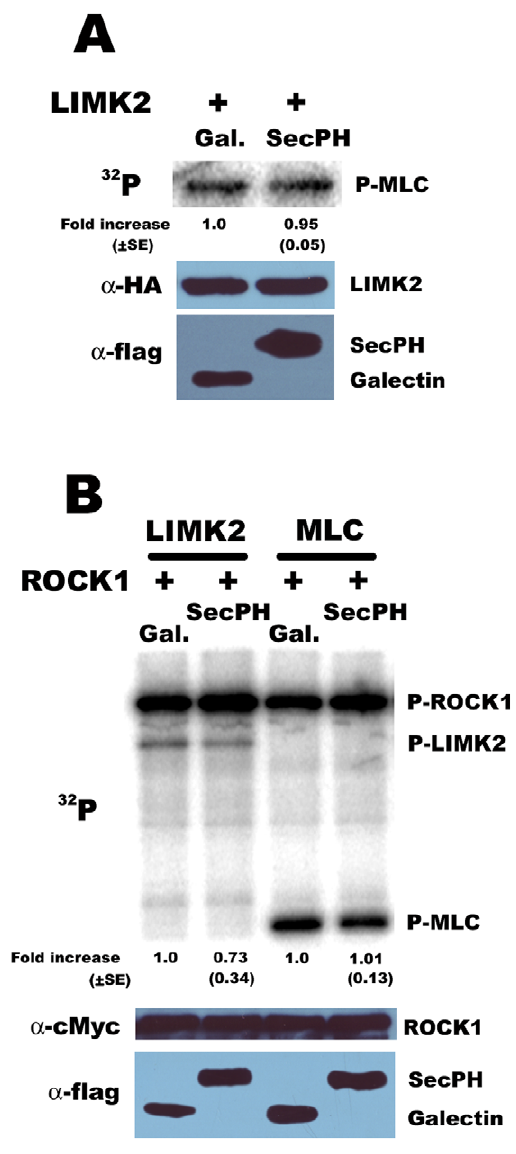
Figure 5. SecPH affects ROCK kinase activity specifically with respect to LIMK2. A. MLC phosphorylation is not affected by SecPH. Same as Figure 2B, except 0.5 m g of MLC were added in the kinase reaction mixture. Each value represents the mean 6 SE (standard error) of two independent experiments. B. MLC phosphorylation by ROCK-1 is not affected by SecPH. Cells were cotransfected with ROCK1 and SecPH or Galectin-3. Immunoprecipitated c-Myc-ROCK1 was used for the kinase assay in the presence of recombinant LIMK2 or MLC (0.5 m g each). The kinase activity on LIMK2/MLC of immunoprecipitated c-Myc- ROCK from cells cotransfected with Galectin-3 was taken as 1.0. Each value represents the mean 6 SE (standard error) of four independent experiments. Immunoprecipitates were also submitted to c-Myc- immunoblotting and lysates to flag-immunoblotting. Ran and Arf. Acting as molecular binary switches, these small GTPases regulate many major biological processes, such as cell cycle progression, cell survival, actin cytoskeleton organization, cell polarity and movement, and vesicular and nuclear transport. Extensive cross-talks between these different small GTPases have been demonstrated [1,37,38,39].